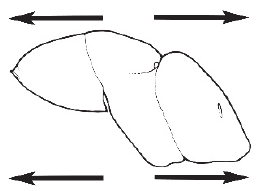
24 In profile, mesosoma of minor worker with a compact appearance, its dorsal outline describing a pronounced arc due to shape of the mesonotum and mesopleuron (mesosternal outline and dorsum of mesonotum strongly convergent anteriorly) ...............................................................................